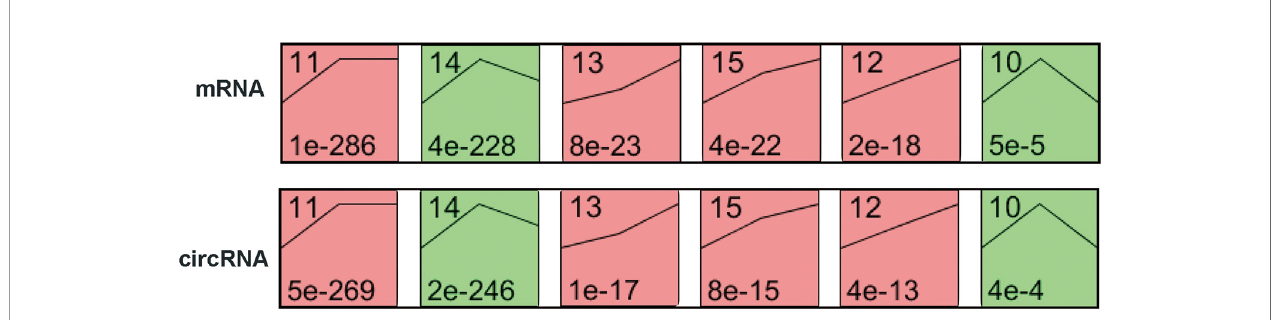
FIGURE 4 | STEM identi fi ed the temporal expression pro fi les of mRNAs and circRNAs with p < 0.05. The black lines in the pro fi le boxes depict the gene expression patterns over the three time points. The pro fi le number on the top left corner of each pro fi le box was assigned by STEM, and the number on the bottom left represents the adjusted p -value. Pro fi les 12, 13 and 15 had the same continuous upregulation patterns. STEM, short time-series expression miner.